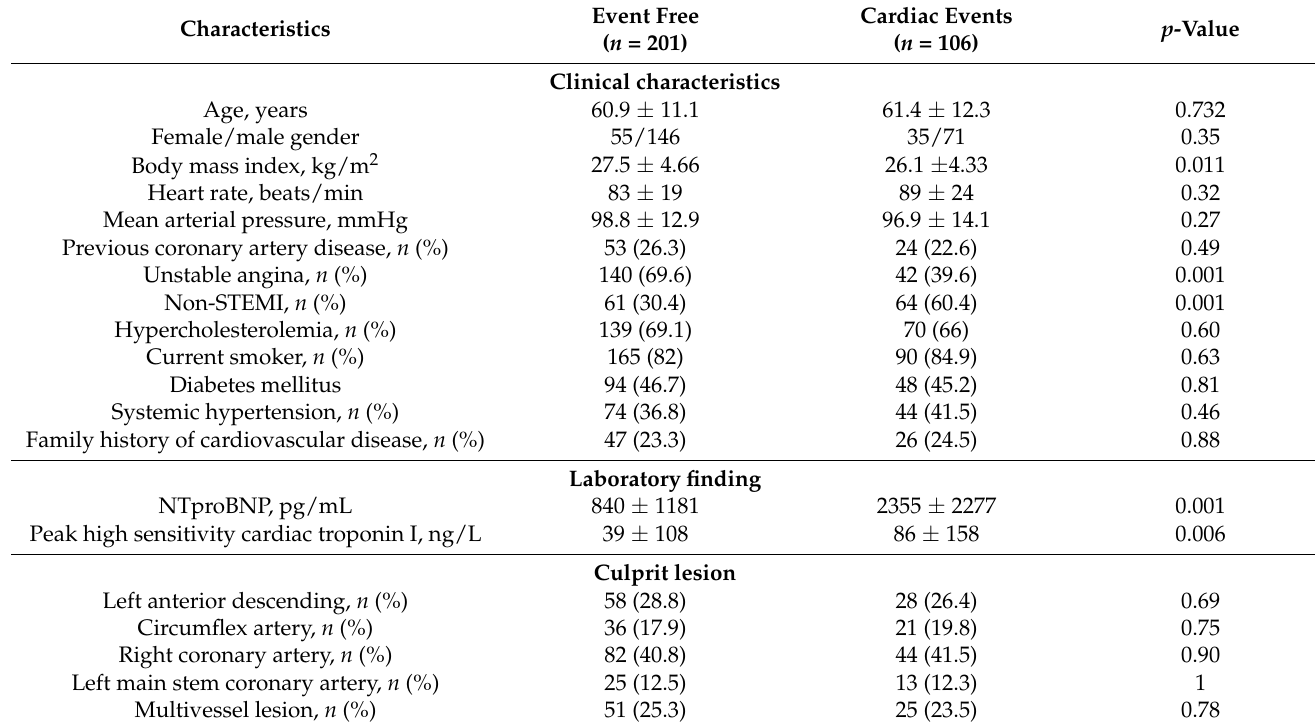
Table 1. Baseline characteristics of the study